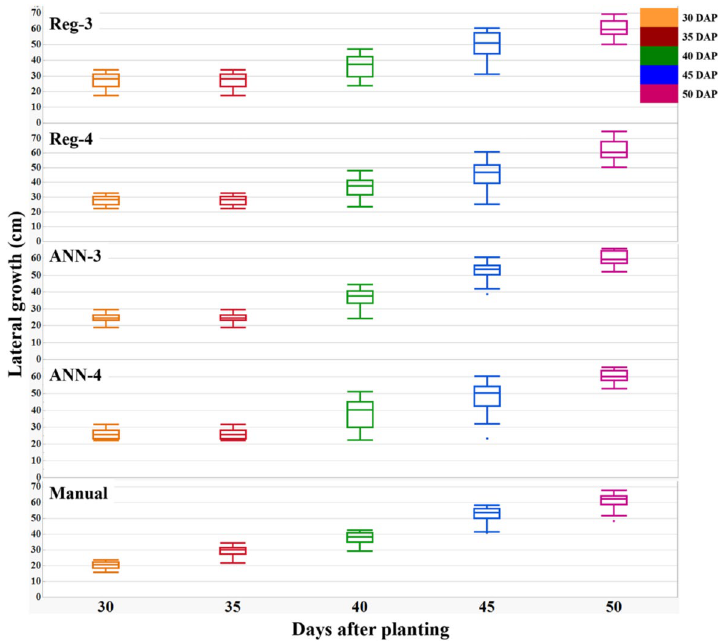
Figure 10. The box and whisker plots show the increase in lateral growth (LG) over days after planting (DAP), where LG has been derived using the same models Reg-3: LG = 254.26 × NPPR + 136.76 × NCPI-92.73 × NGRDI- 82.78 × PPR-144.24; Reg 4: LG = 3372.55 × (PPR × NPPR × NGRDI × NCPI) + 19.96. ANN-3: PPR, NPPR, NGRDI, and NCPI as predictors of LG; ANN-4: product of PPR, NPPR, NGRDI, and NCPI as predictors of